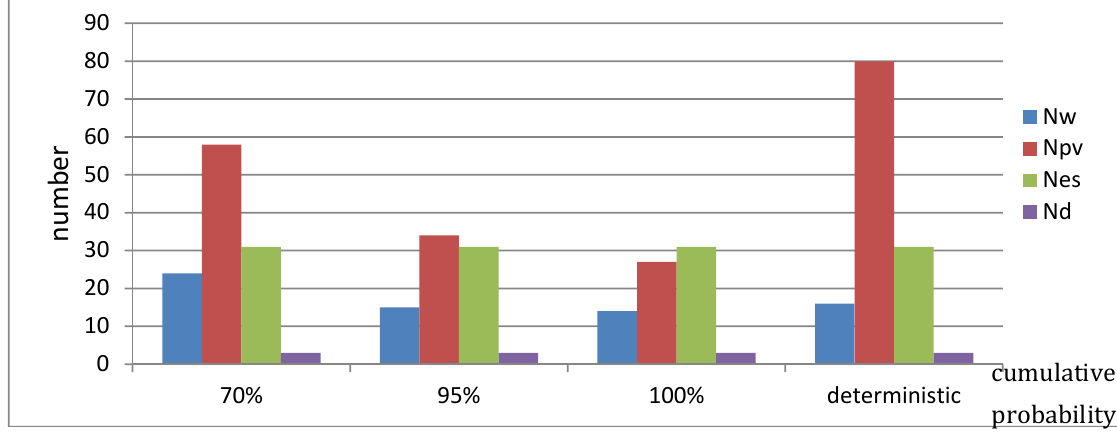
Figure 6. Numbers of WTG, PV, ES, and diesel generators considering deterministic method and different cumulative